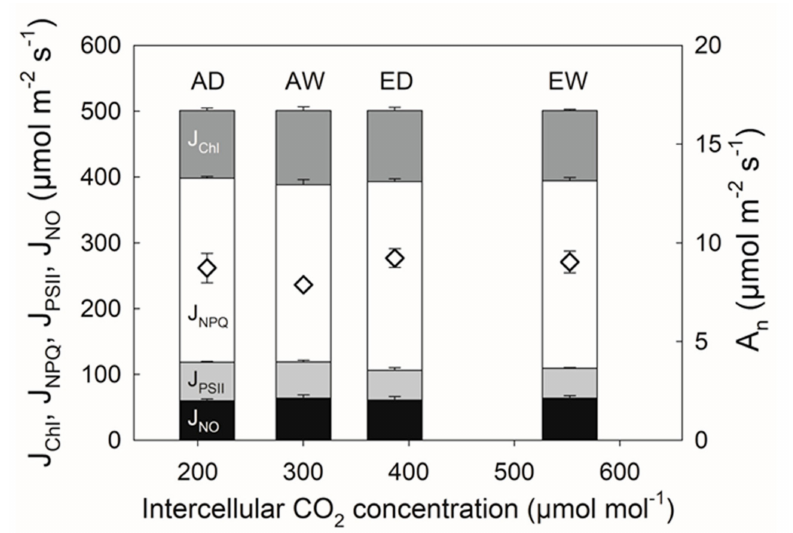
Figure 2. Fate of light energy partitioning with drought under elevated CO 2 . Data are plotted as a function of intercellular CO 2 concentration. J Chl , J NPQ , J PSII and J NO were measured in the